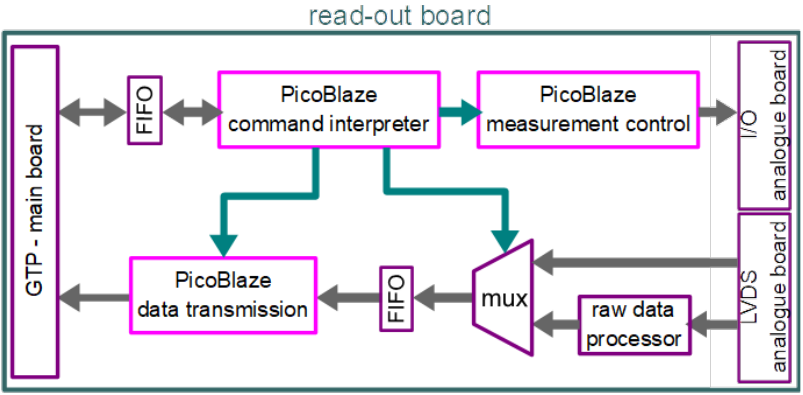
Figure 2. Blocks of VHDL code at read-out